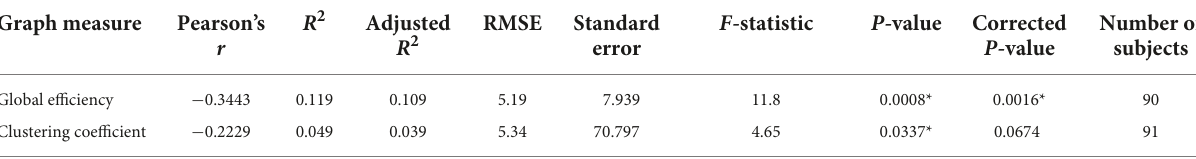
*Indicates the p -values that were statistically significant ( p < 0.05). RMSE, root mean square error; Corrected p -value = The p -value after multiple comparisons using